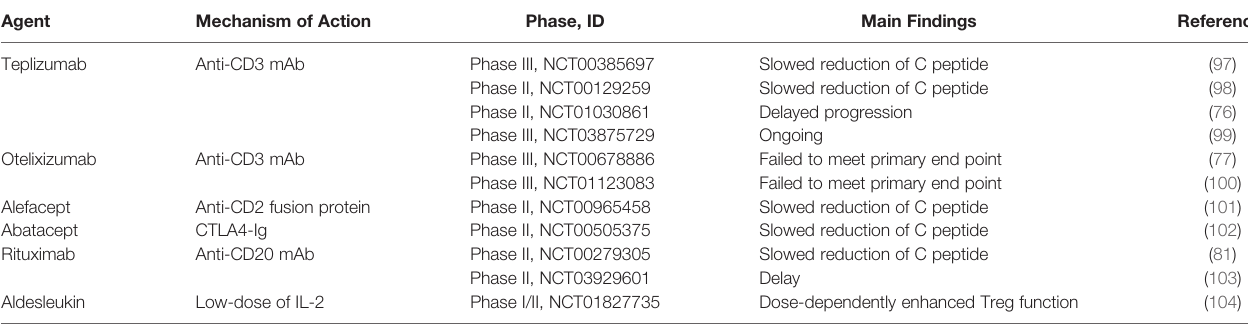
TABLE 1 | Summary of major clinical trials for anti-in fl ammatory therapies on T1D.